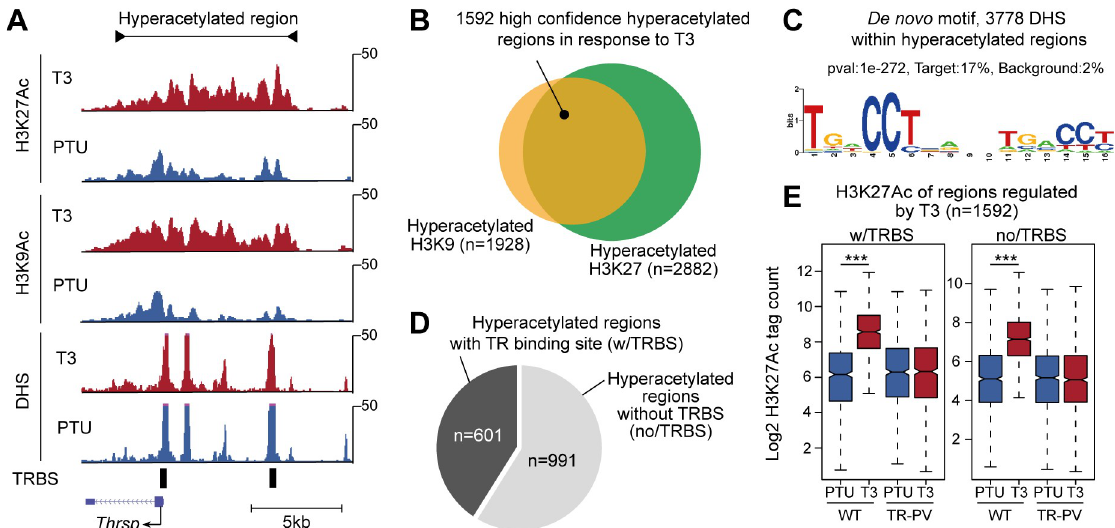
Fig 1. Identification of T3-regulated hyperacetylated regions in the liver. (A) Example of increased H3K9 and H3K27 acetylation at DHSs near the Thrsp gene. TR binding sites (TRBSs) identified from TR ChIP-seq data are indicated as black bars. The identified hyperacetylated region is displayed above density graphs of sequenced tags. (B) 1592 regions hyperacetylated at both H3K9 and H3K27 constitute high confidence hyperacetylated regions in hyperthyroid condition. (C) De novo motif analysis of 3778 DHSs within hyperacetylated regions. The most enriched motif is shown. (D) Relative amount of hyperacetylated regions with at least one TRBS based on TR ChIP-seq data. (E) T3-induced H3K27Ac in mice expressing TR-PV mutant lacking a functional activating helix 12. Statistical difference was determined by a Wilcoxon Signed Rank Test, ��� p <